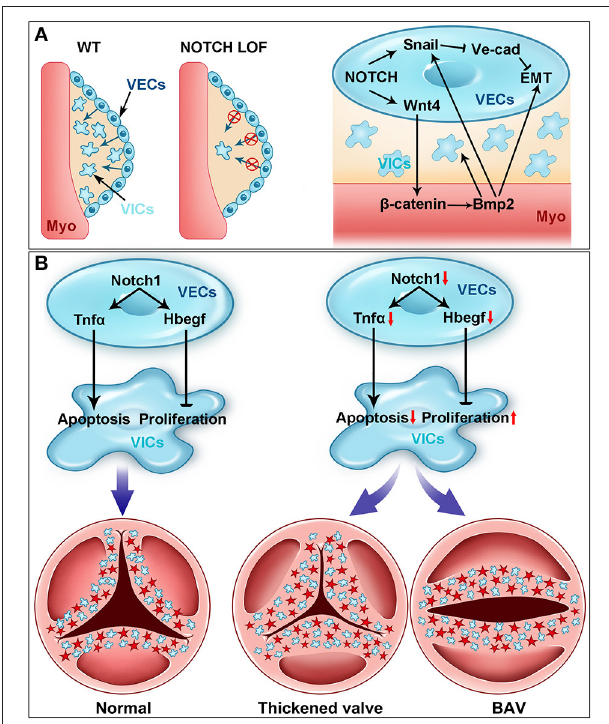
FIGURE 3 | NOTCH signaling in cardiac valve development. (A) NOTCH is essential for early heart valve development (i.e., endocardial cushion formation). Cardiac valve development starts with the formation of endocardial cushions through the endocardial-to-mesenchymal transformation (EMT) (blue arrows) process in wild-type (WT) mouse embryos. The EMT process is severely blocked in the NOTCH loss-of-function (LOF) mutant